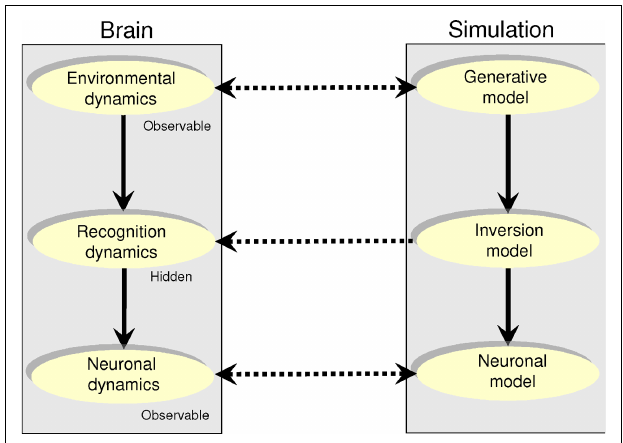
FIGURE 4 | Modeling neuronal dynamics caused by environmental dynamics. Brain system (left): In this dual-system model, neuronal dynamics (bottom) correspond to inversion or recognition dynamics (middle) induced by environmental dynamics (top). We assume that the environmental and neuronal dynamics can be partially observed, while the recognition dynamics are hidden. Simulated system (right): The full generative model of neuronal dynamics; starting with environmental dynamics, which specify recognition dynamics, which predict neuronal